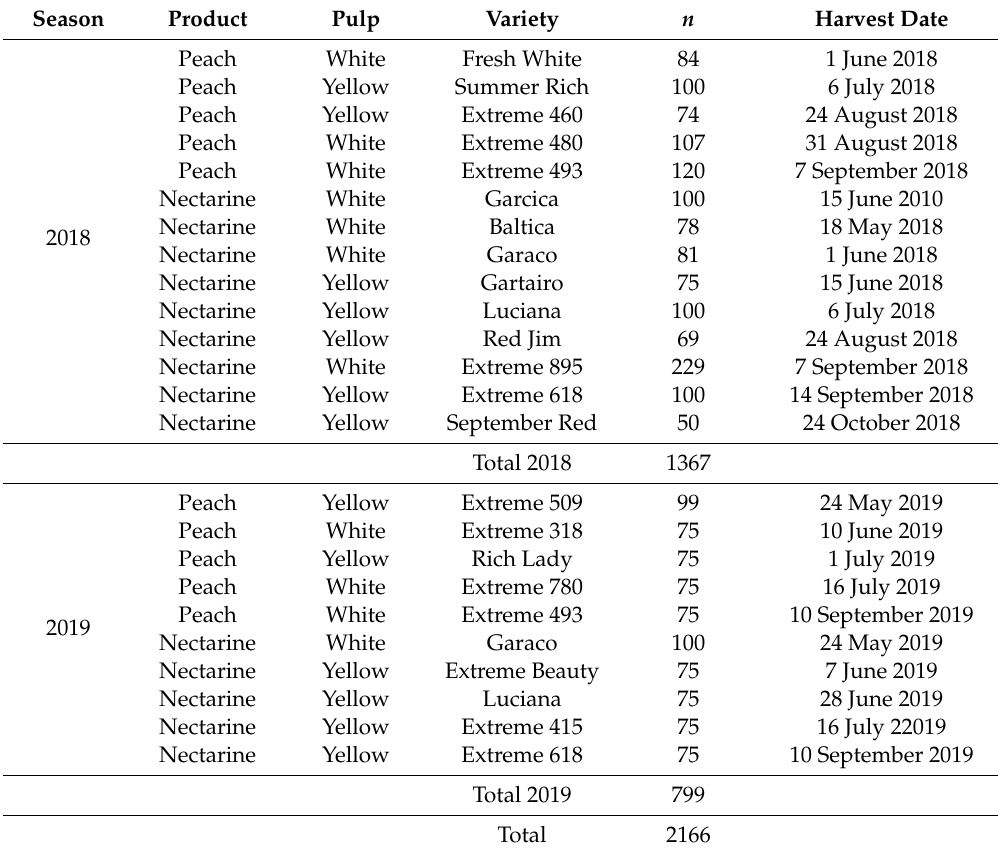
Table 1. Characteristics of the plant material tested; season, product, type of pulp, variety, number of fruits ( n ) and harvest